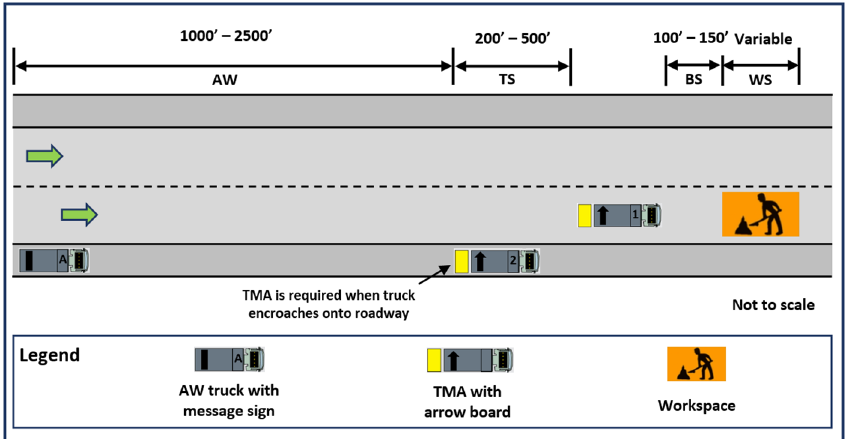
Figure 2. Recommended minimum requirements for a right lane closure * [14]. * AW: Advance Warning; TS: Transition Space; BS: Buffer Space; WS: Workspace. If the closed lane is a left lane (Figure 3), the arrow board should be set to the blinking right arrow mode, and the advance warning sign should read Left Lane Closed . Correspond- ingly, a PCMS should alternately read Left Lane Closed and Move Right Now .